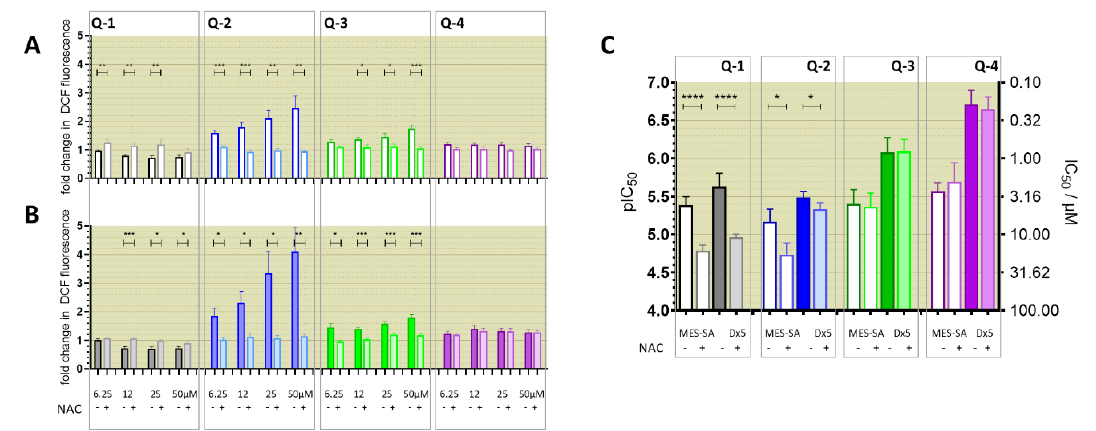
Figure 7. Intracellular ROS production was measured upon incubation of MES-SA ( A ) and MES-SA/Dx5 ( B ) cells with increasing concentrations of Q-1 to Q-4 ranging from 6.25 µM to 50 µM in the absence (darker) or presence (lighter) of 5 mM NAC. Fold changes in fluorescence are shown after a 2 h incubation with the respective compounds. Data of the differently chlorinated ligands as well as of cell free controls are shown in Table S3. ( C ) Effect of NAC (5 mM) on the toxicity of Q-1 to Q-4 . Average pIC 50 values and standard deviations are shown for Pgp-negative MES-SA (open columns) and Pgp-positive MES-SA/Dx5 cells (filled columns) in the absence (intense) and presence (pale) of 5 mM NAC. For comparison, the respective µ M concentrations are shown on the right y -axis. NAC alone (5 mM) did not influence the viability of the cells (see Table S2). Significance was calculated using unpaired t -tests; results are given as *: p ≤ 0.05, **: p ≤ 0.01, ***: p ≤ 0.001, ****: p ≤ 0.0001.